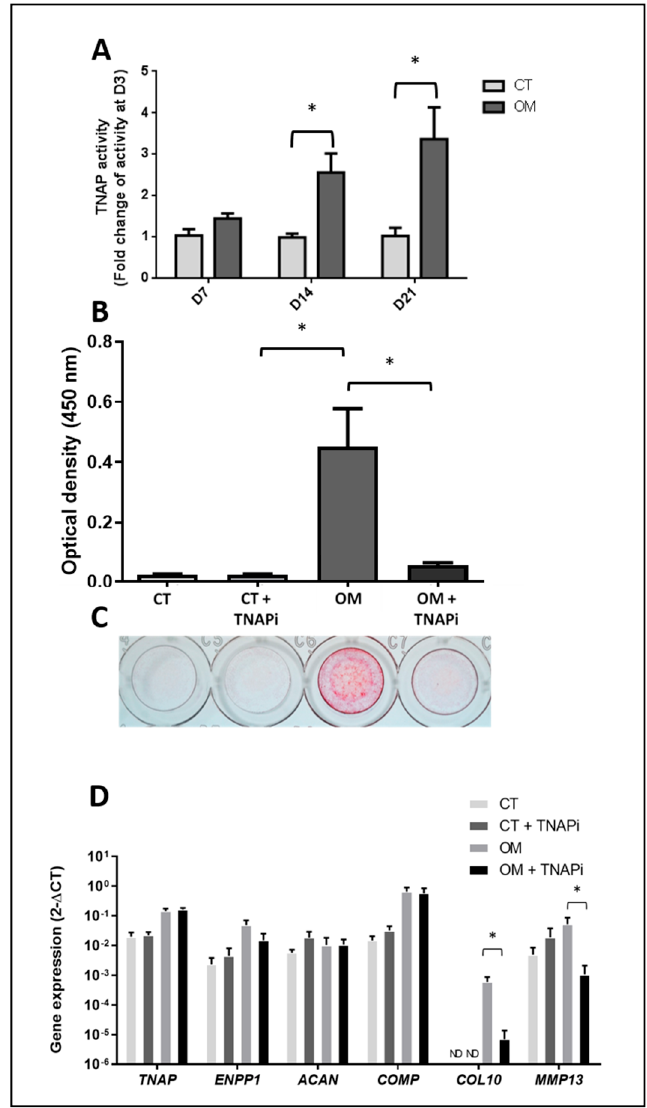
Figure 3. Study of TNAP involvement in the mineralization process. ( A ) TNAP enzymatic activity over time for the two conditions ( N = 3). ( B ) Effects of a TNAP inhibitor on the mineral deposition ( N = 3) assessed by the colorimetric method after the solubilization of alizarin red. ( C ) Representative images of alizarin red staining of wells of one patient. CT: control medium; OM: osteogenic medium; TNAPi: TNAP inhibitor. ( D ) Gene expression by TLC after treatment with a TNAP inhibitor ( N = 3). TNAP: tissue non-specific alkaline phosphatase; ENPP1: ectonucleotide pyrophosphatase/phosphodiesterase; ACAN: aggrecan; COMP: cartilage oligomeric matrix protein; COL10: type X collagen; MMP13: matrix metallopeptidase 13; CT: control; OM: osteogenic medium; TNAPi: TNAP inhibitor; ND: not detected. * = p < 0.05.